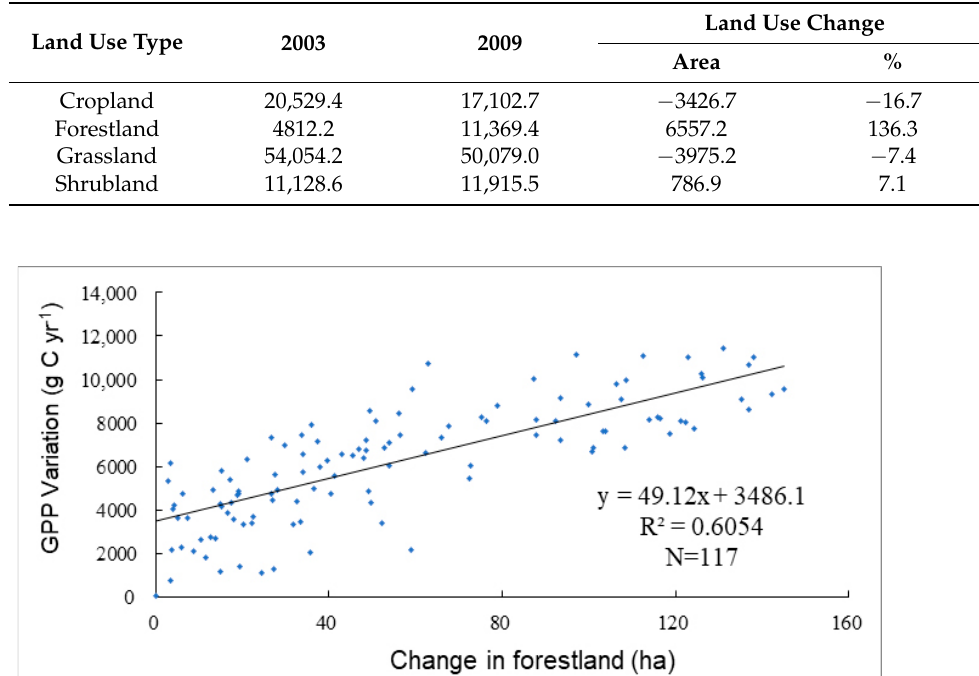
Figure 8. Relationship between changes in GPP and forestland area between 2003 and 2009 in the typical region.